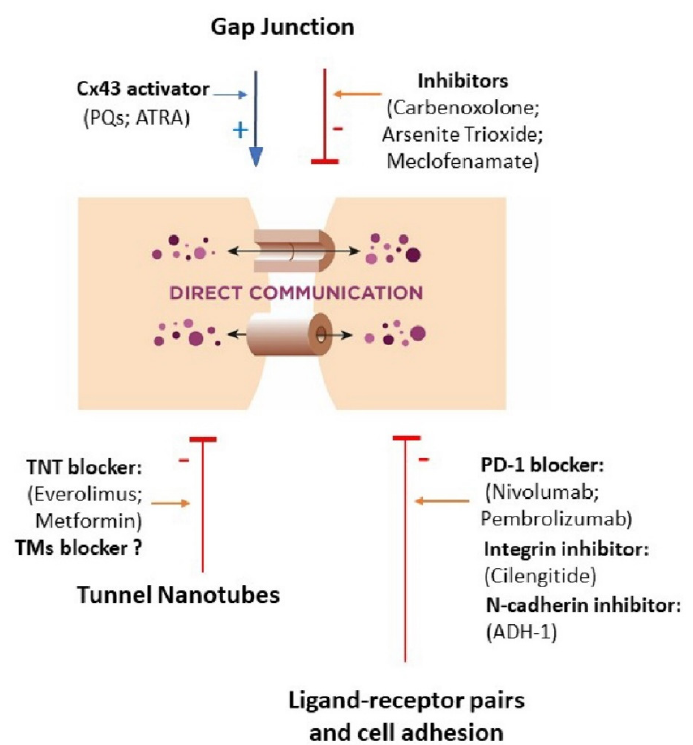
Figure 3. New therapeutic actions targeted at direct communication in the cancer microenvironment. Two ways of therapeutic options are being considered: the first is focused on attenuation or inhibition of cell–cell interaction (red lines), and the second is based on its intensification (blue arrows). ATRA—all-trans retinoic acid; Cx—connexin; TMs—tumor microtubes; TNT—tunnel nanotube.